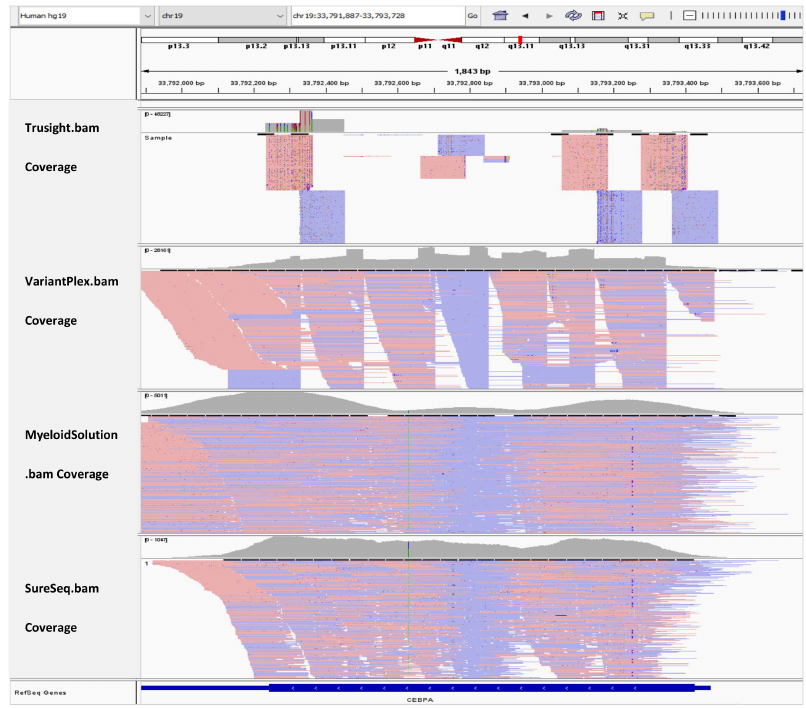
Figure 2. IGV tracks of CEBPA exon 1.